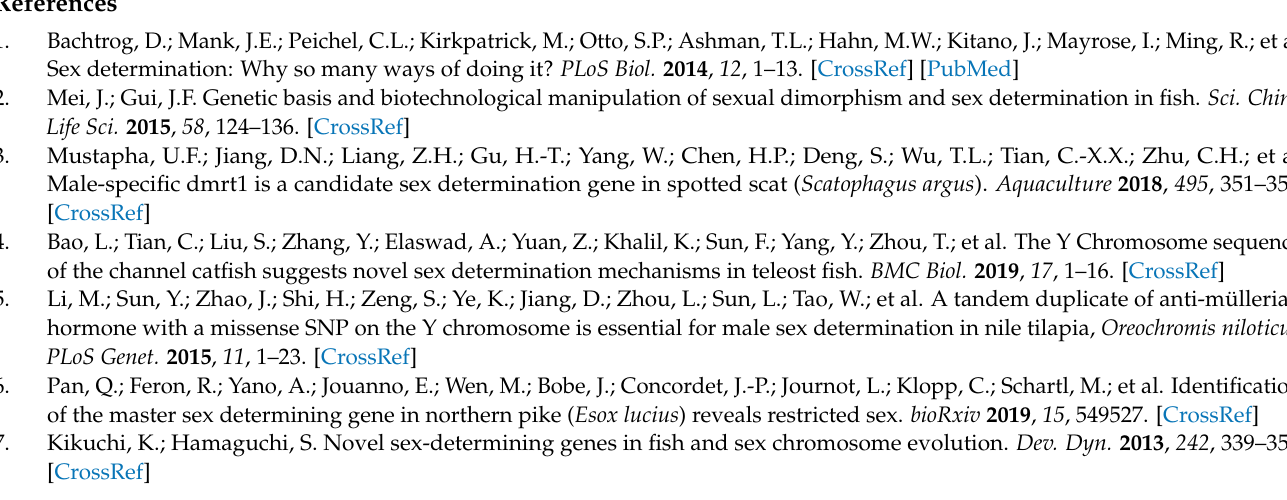
study. Figure S3. A) Dmrt2a transcript expression by transcriptome analysis. i) Dmrt2a FPKM and reads values from 6 male and 6 female transcriptome data. ii) Graph of average FPKM values and reads numbers from the 6 males and females in "i" above. B) The proportion of G and A